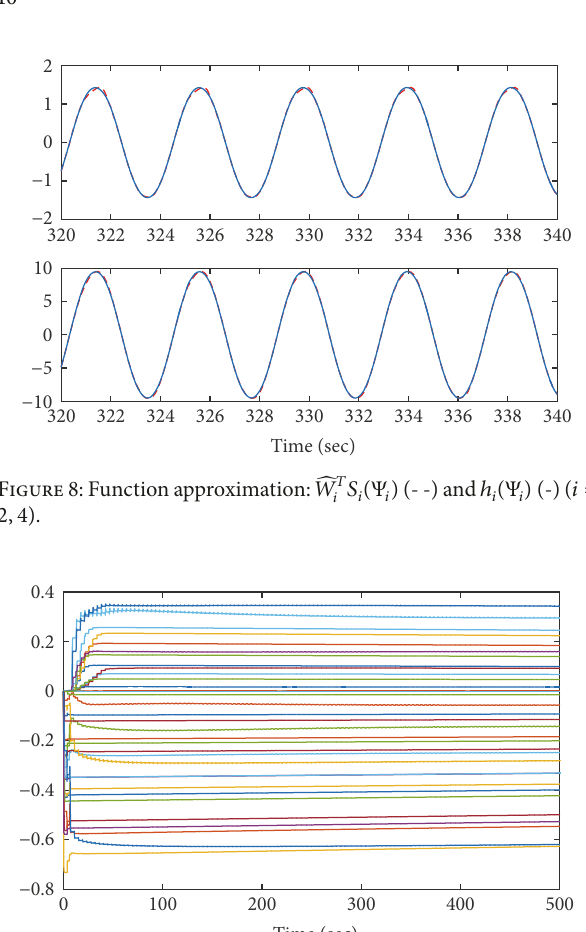
Figure 9: The convergence of partial NN weights